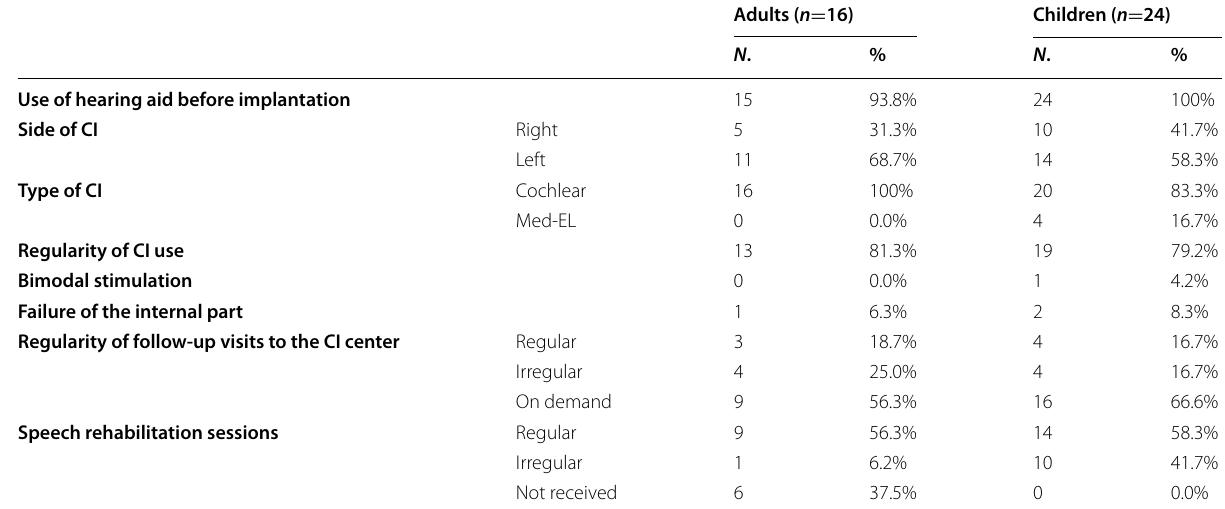
Table 3 Distribution of the study group according to rehabilitation history